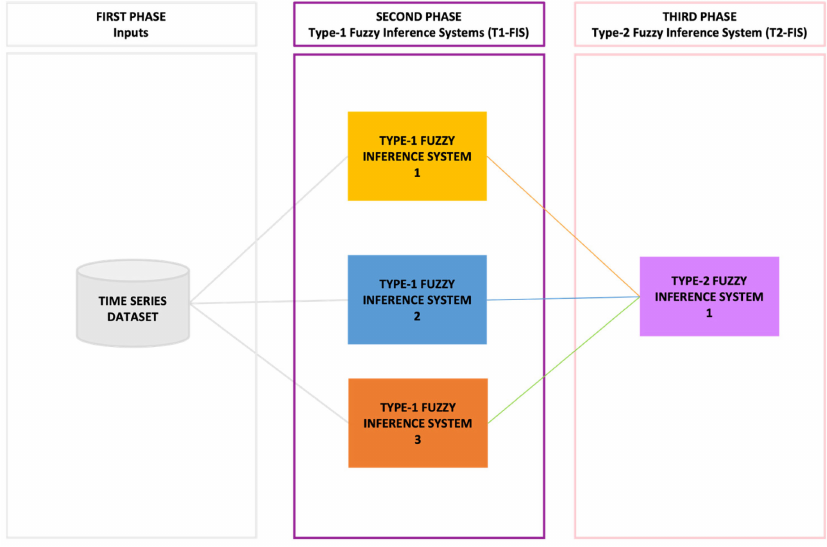
Figure 4. Illustration of the proposed